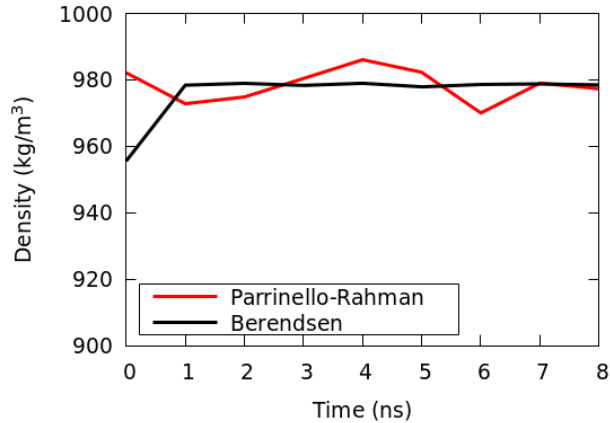
Figure 2. Time behavior of mass density for the Berendsen (black) and Parrinello – Rahman (red) barostat algorithms. Only the last 8 ns of trajectory, starting from a well-equilibrated sample, are shown.